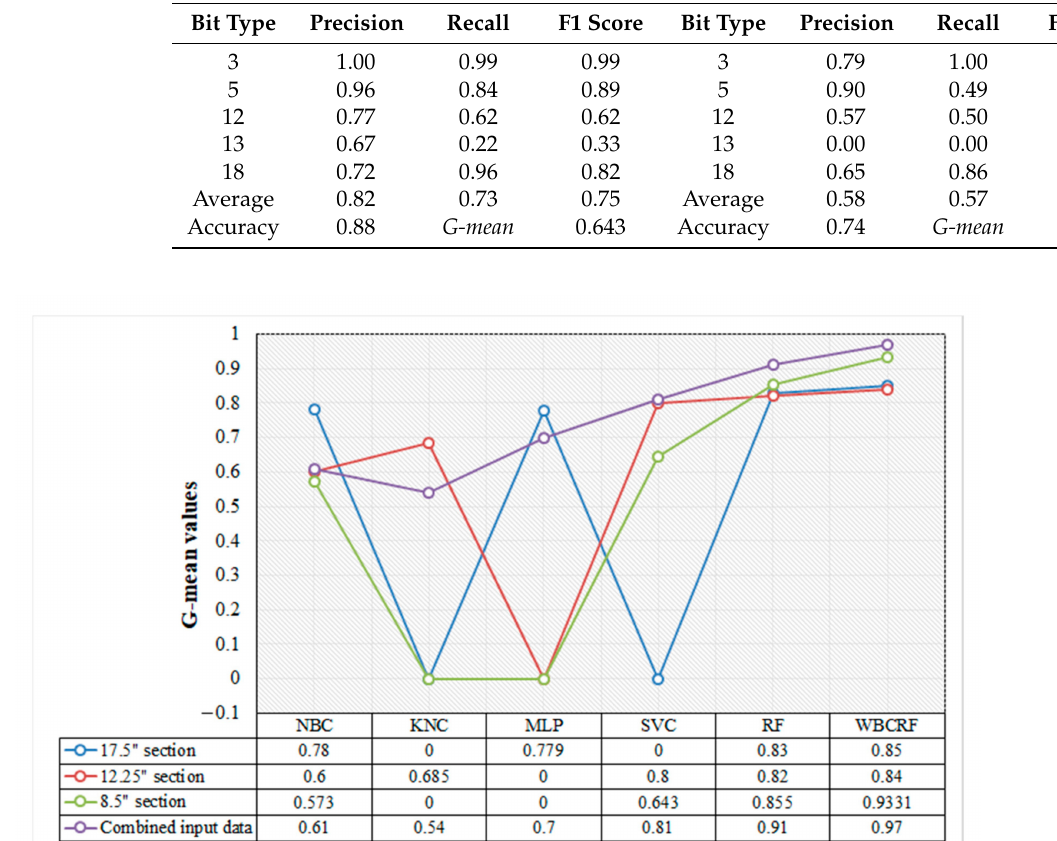
Figure 14. Summary of G-mean scores achieved by intelligent models for both experimental